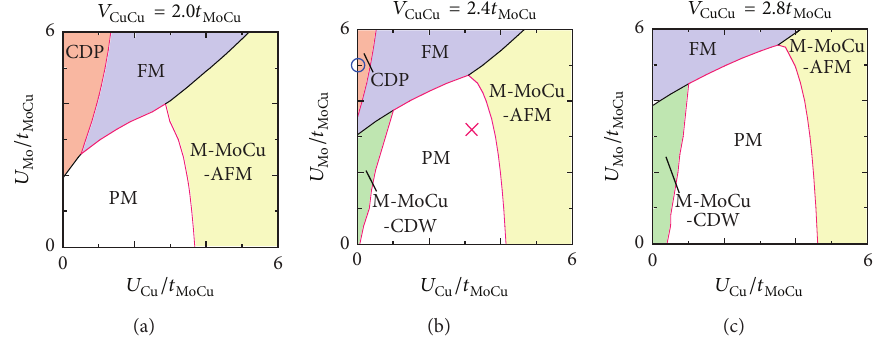
= 0.3𝑡 = Figure 3: Ground-state phase diagrams as functions of the on-site Coulomb repulsions 𝑈 and 𝑈 , where 𝑡 , 𝑉 Cu Mo CuCu MoCu MoCu − 𝜀 = 1.0𝑡 = 𝐽 󸀠 = −𝐽 = −𝐽 󸀠 = 0.6𝑡 0.8𝑡 , 𝜀 , and 𝐽 . M-MoCu-AFM and M-MoCu-CDW each include two MoCu Cu Mo MoCu MoCu CuCu MoCu MoCu CuCu isoenergetic phases of 𝐴 𝑔 and 𝐵 𝑔 symmetry, referred to as (1)and (2), respectively. Phaseboundaries drawn in black and red denote transitions of the first and second order, respectively. We calculate optical properties of the PM state labeled × . The CDP state labeled ∘ is discussed later in connection with photoexcitation of the PM